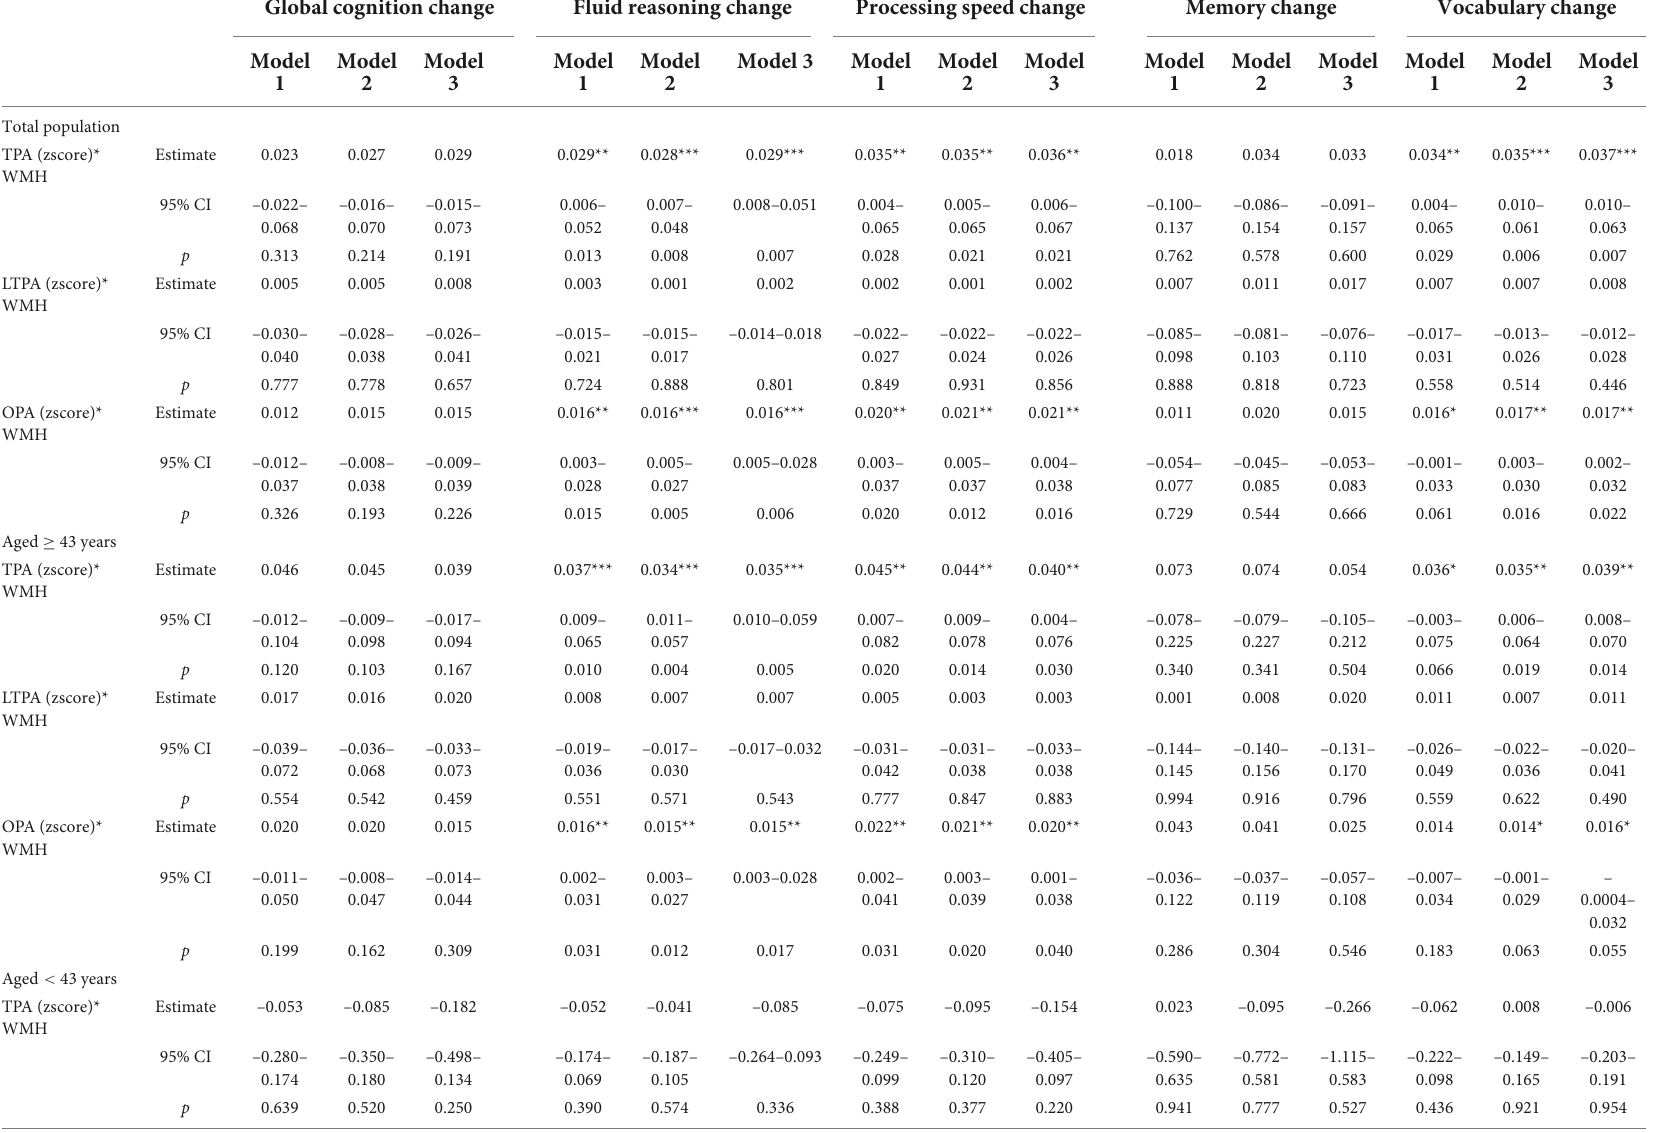
TABLE 4 The interaction of physical activity (PA) with white matter hyperintensity (WMH) on cognitive